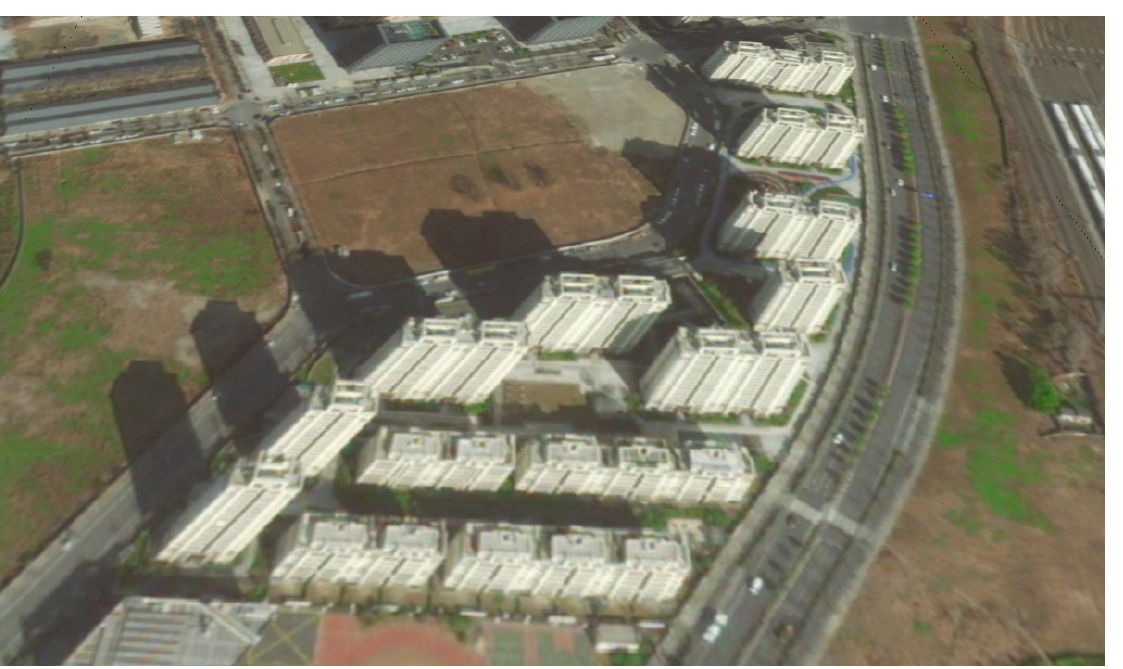
Figure 6. Hangzhou Landsea Huafu Residential District (from Baidu Map).